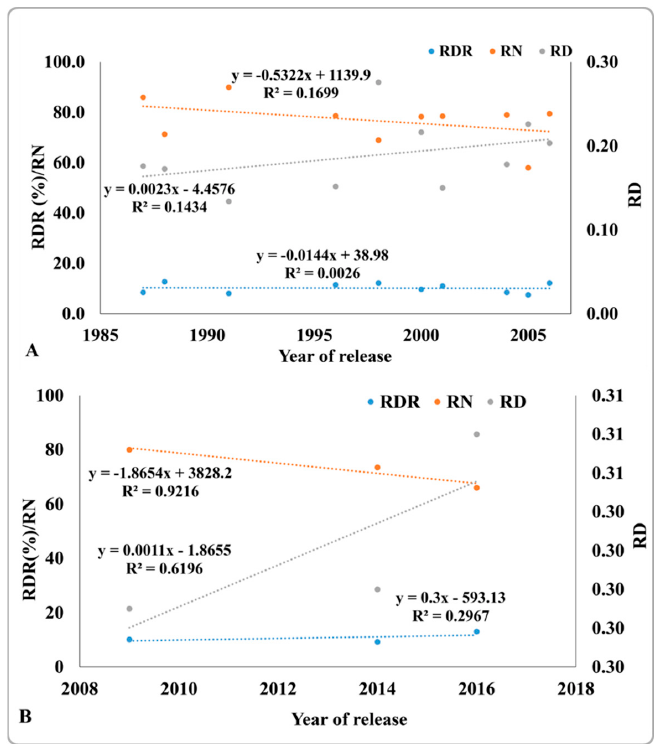
Figure 7. Ratio of deep rooting (RDR), total number of roots in the crown region (RN), and root diameter (RD) of varieties released from 1987 to 2006 ( A ) and from 2009 to 2016 ( B ). Values are the mean of three replicates per variety per year of release. Genotypes 1 to 24 from Tables 2 and 3 were used here.